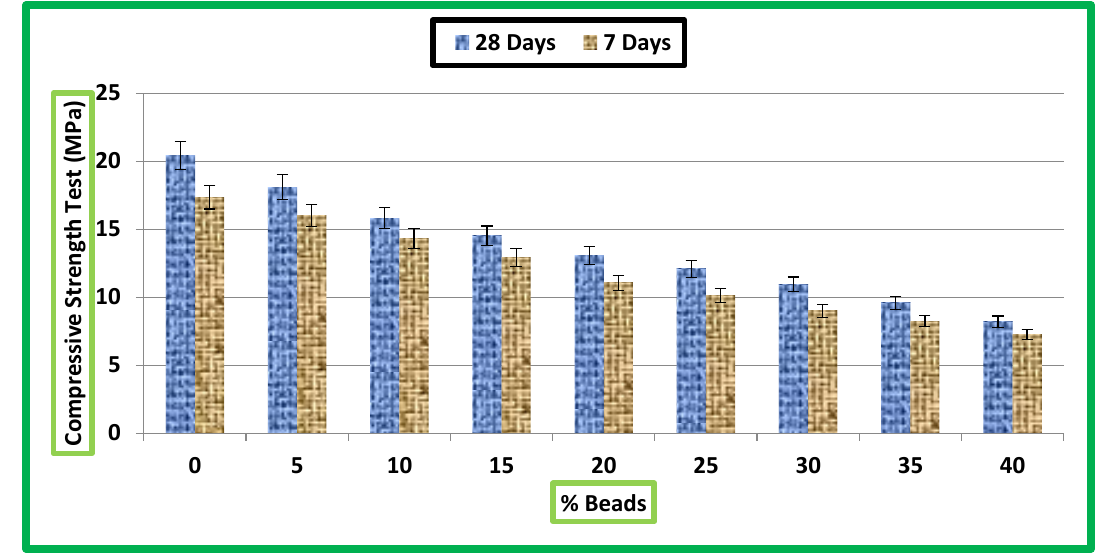
Figure 13. The compressive strength of EPS-beads lightweight concrete.